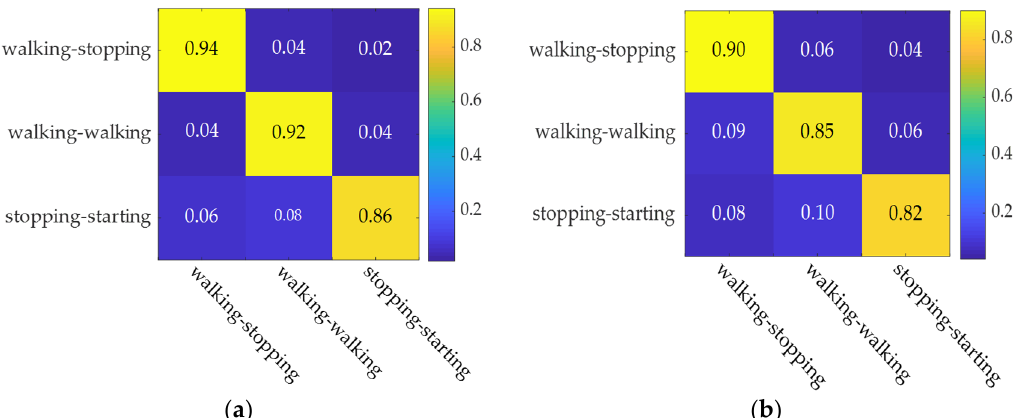
Figure 13. ROC curve of model identification 0.6 s in advance.